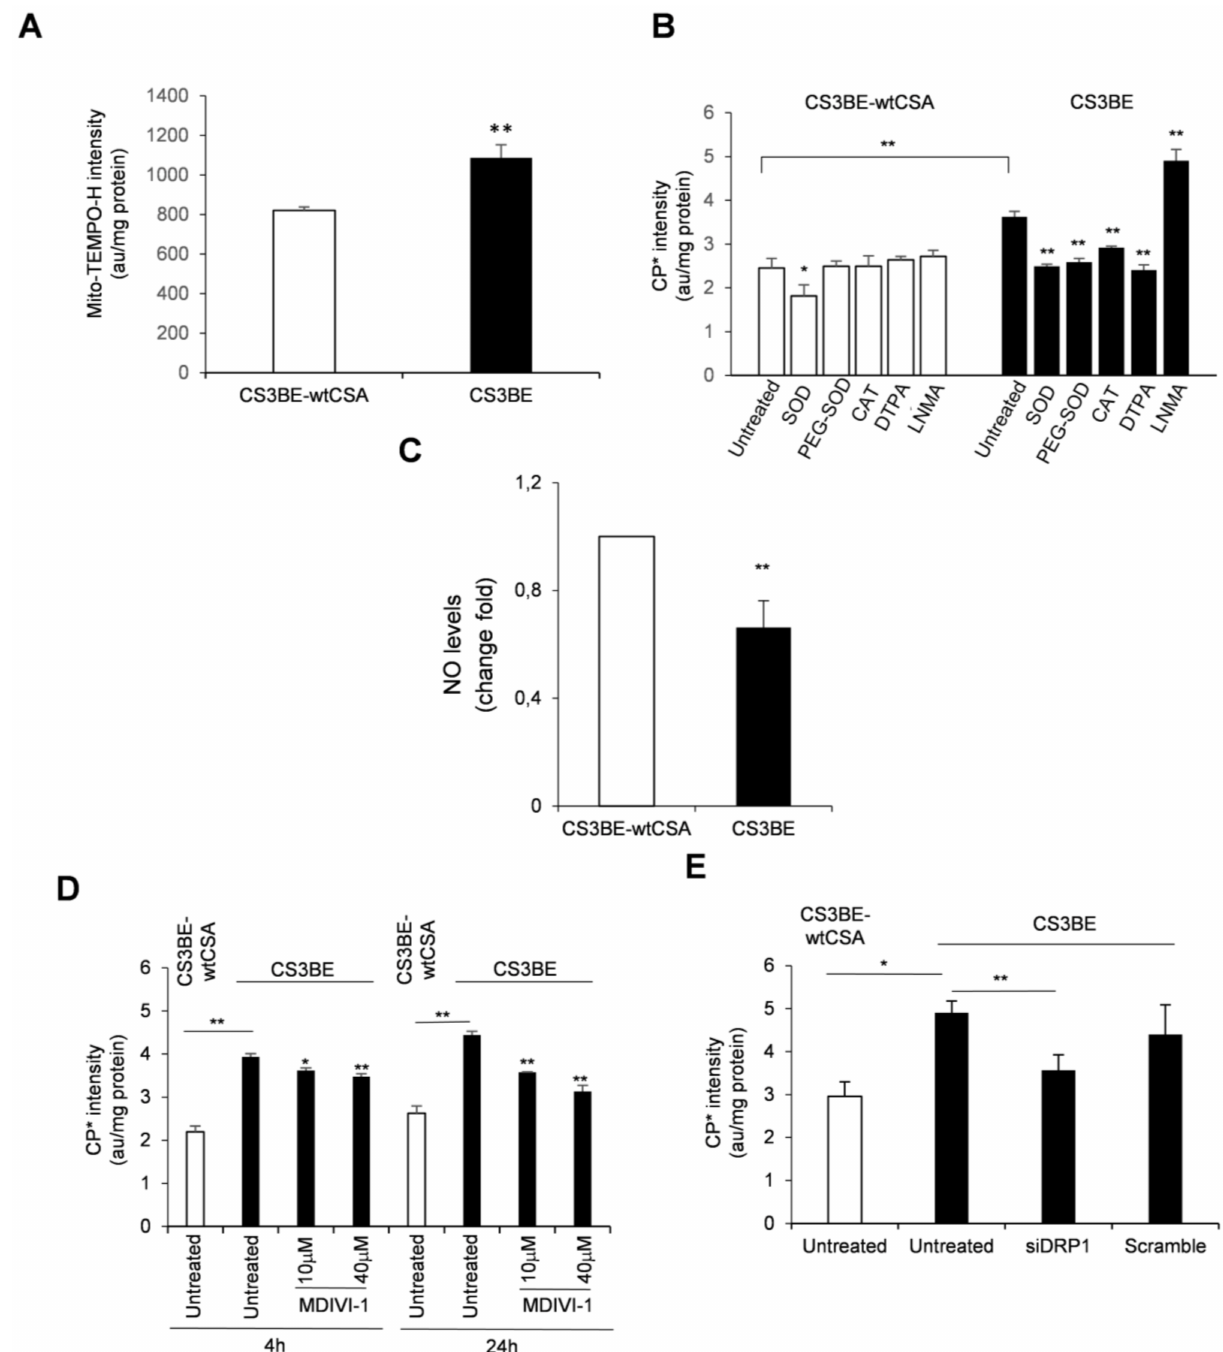
Figure 4. ( A ) Mitochondrial ROS levels assessed by EPR technique by using the cyclic hydroxylamine spin probe Mito- TEMPO-H in CS3BE and CS3BE-wtCSA cells. ( B ) ROS species characterization in CS3BE and CS3BE-wtCSA cells by competition with the suitable scavengers for O2- • and H 2 O 2 as indicated. SOD, superoxide dismutase; PEG-SOD, superoxide dismutase conjugated to polyethylene glycol (PEG); CAT, catalase; DTPA, diethylenetriamine pentaacetic acid, and NMA, N-monomethyl-L-arginine. ( C ) NO levels in CS3BE and CS3BE-wtCSA cells measured by DAF-FM-DA. D, E. ROS levels assessed by EPR technique by measuring the intensity of the formed nitroxide 3-carboxyproxyl radical in CS3BE and CS3BE-wtCSA cells after treatment with MDIVI-1 ( D ) or DRP1 silencing ( E ). The reported values are mean ± SD of three independent experiments; * p < 0.05, ** p < 0.01 by paired Student